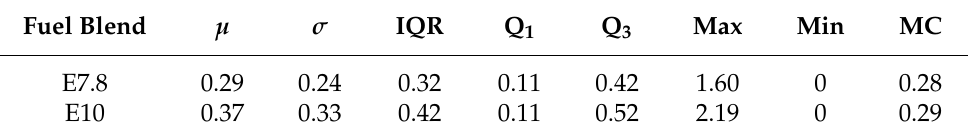
Figure 10. Histogram comparison of fuel flow between fuel blends. Table 6. Fuel consumption statistics comparison between fuel